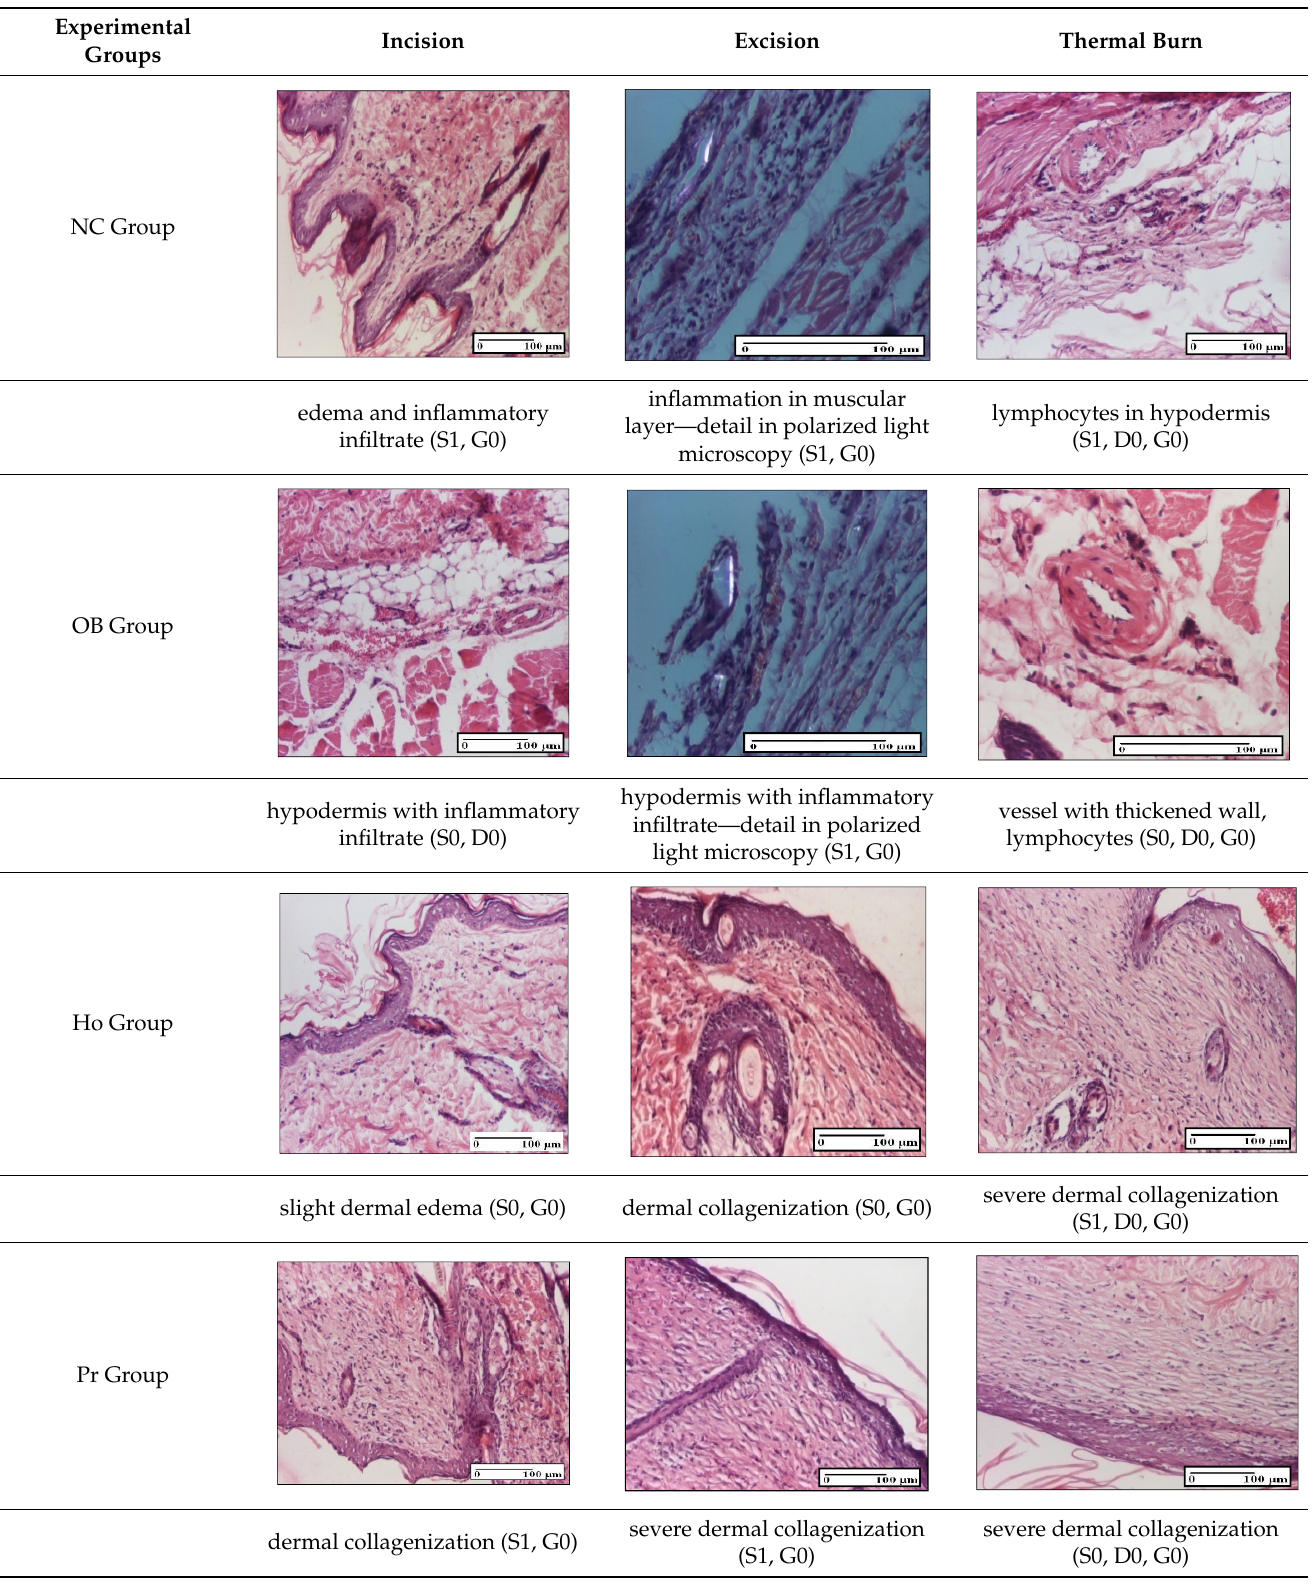
Table 6. Histopathological evaluation of the tissue samples on day 21.